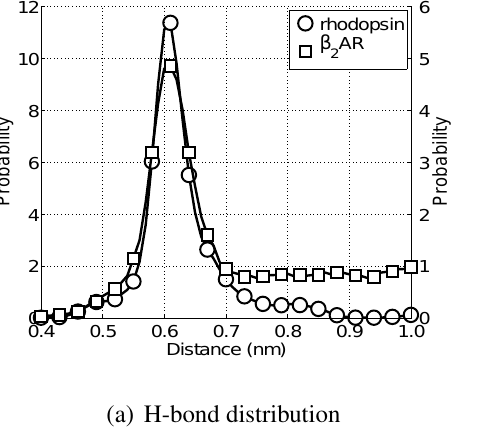
Figure 4. In (a) the distribution of potential H-bonding CG backbone particles along the backbone chain ( i to i + 4 ) is depicted, whereas in (b) the newly developed Lennard-Jones H-bond potential is shown. The dashed line in (b) indicates the curve belonging to a regular Lennard-Jones potential. The important parameters are indicated in the